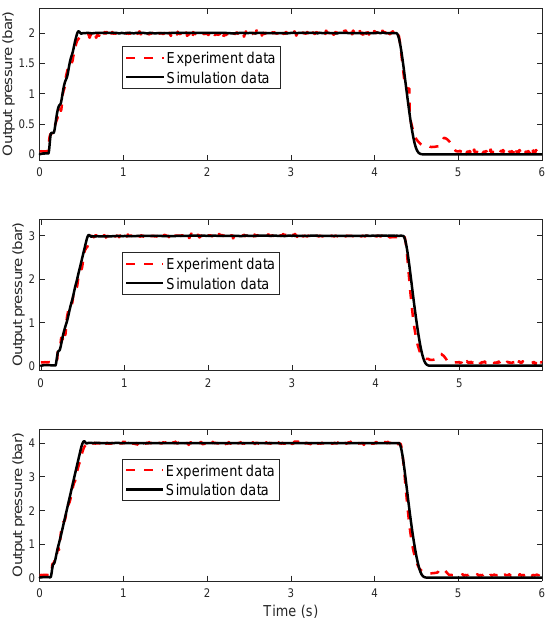
Figure 9. Comparison results between the simulation data and experimental data. From Figure 9, the simulation data fit well with the experimental data, which verified the accuracy of the proposed MPC controller. The gain-scheduled MPC switched among a family of MPC controllers to control the nonlinear brake system based on the interpolation strategy over a wide range of target pressures. To validate the strategy, the gain-scheduled MPC was applied to this system with the complex reference signal. The results are shown in Figure 10. Figure 10 shows the tracking performance and stability of the system with a gain-scheduled MPC